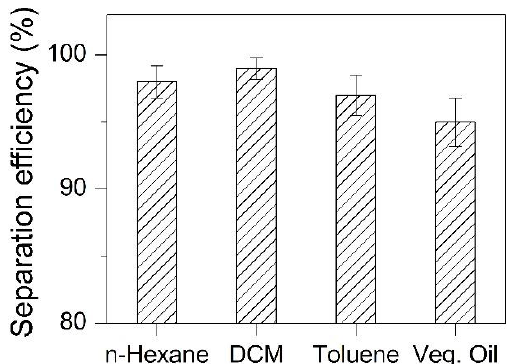
Figure 11. The separation efficiency of modified cotton fabric.